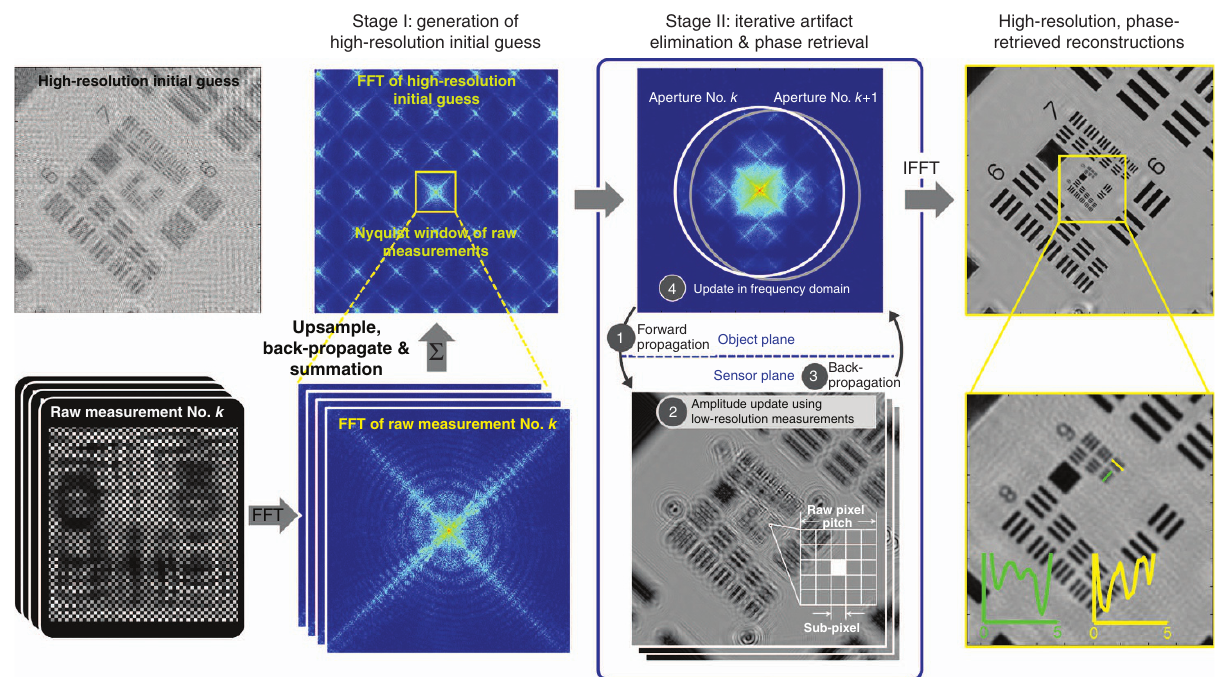
Figure 2 Reconstruction algorithm for wavelength-scanning pixel super-resolution, integrated with multi-height or synthetic-aperture-based lens-free phase retrieval. Refer to the Materials and Methods section for further details. The fourth column shows super-resolved and phase-retrieved reconstruction of the specimen. FFT, fast Fourier transform; IFFT, inverse fast Fourier